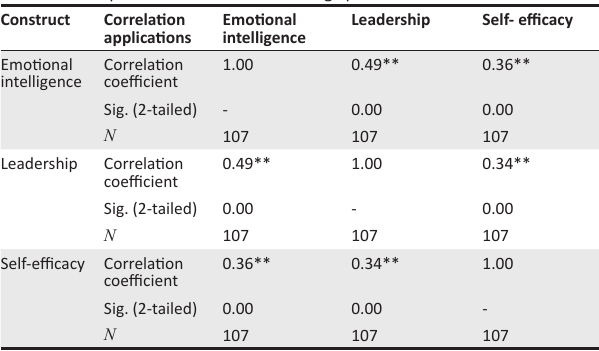
TABLE 6: Non-parametric correlations using Spearman’s rho. Construct